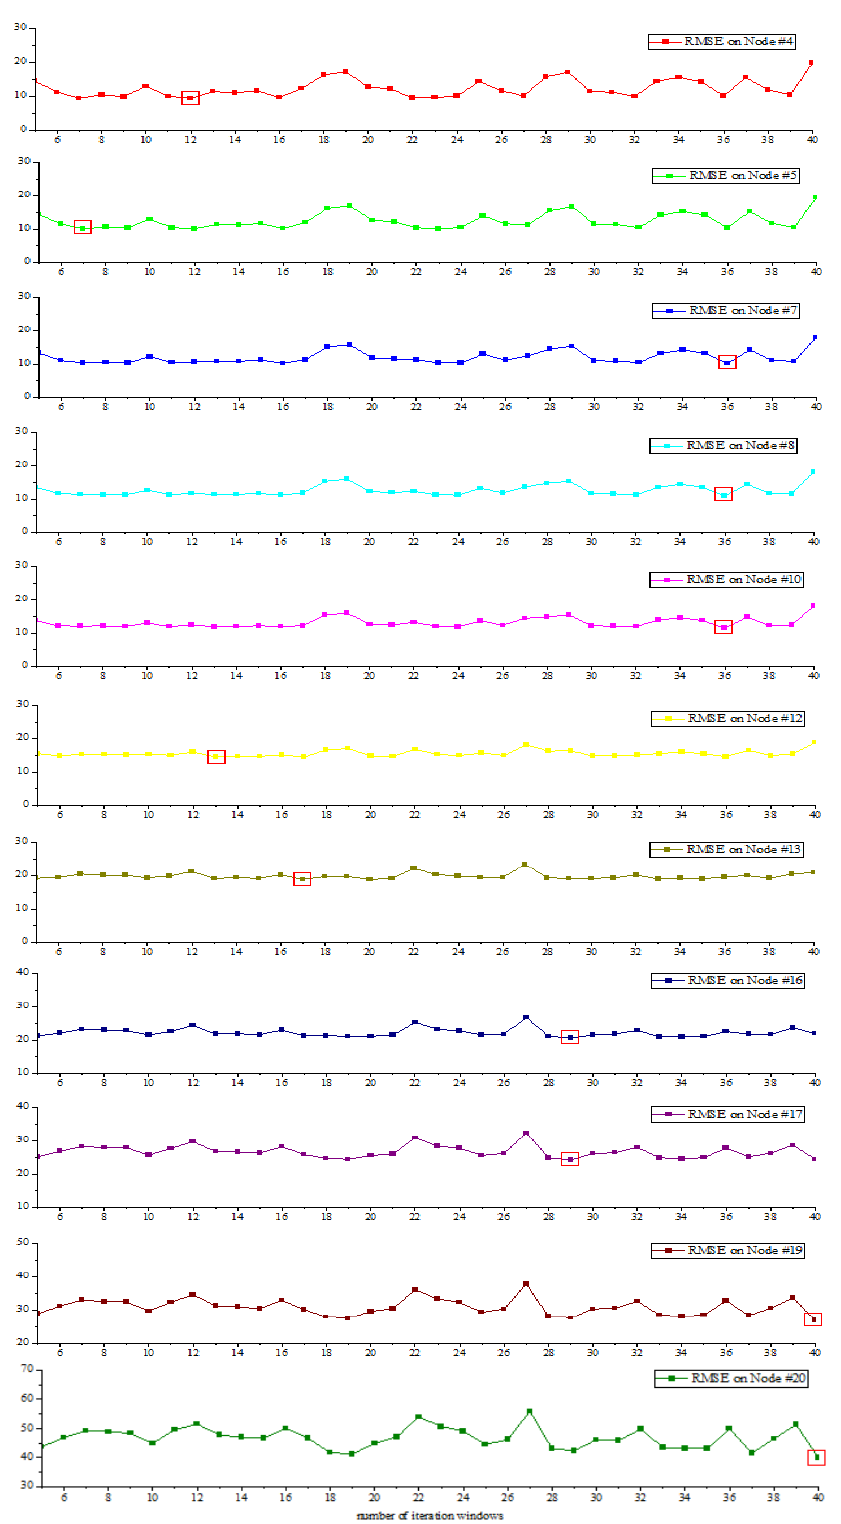
Figure 6. Validation errors of the global models. All the red boxes in the figure represent the current nodes optimal RMSE values that we have